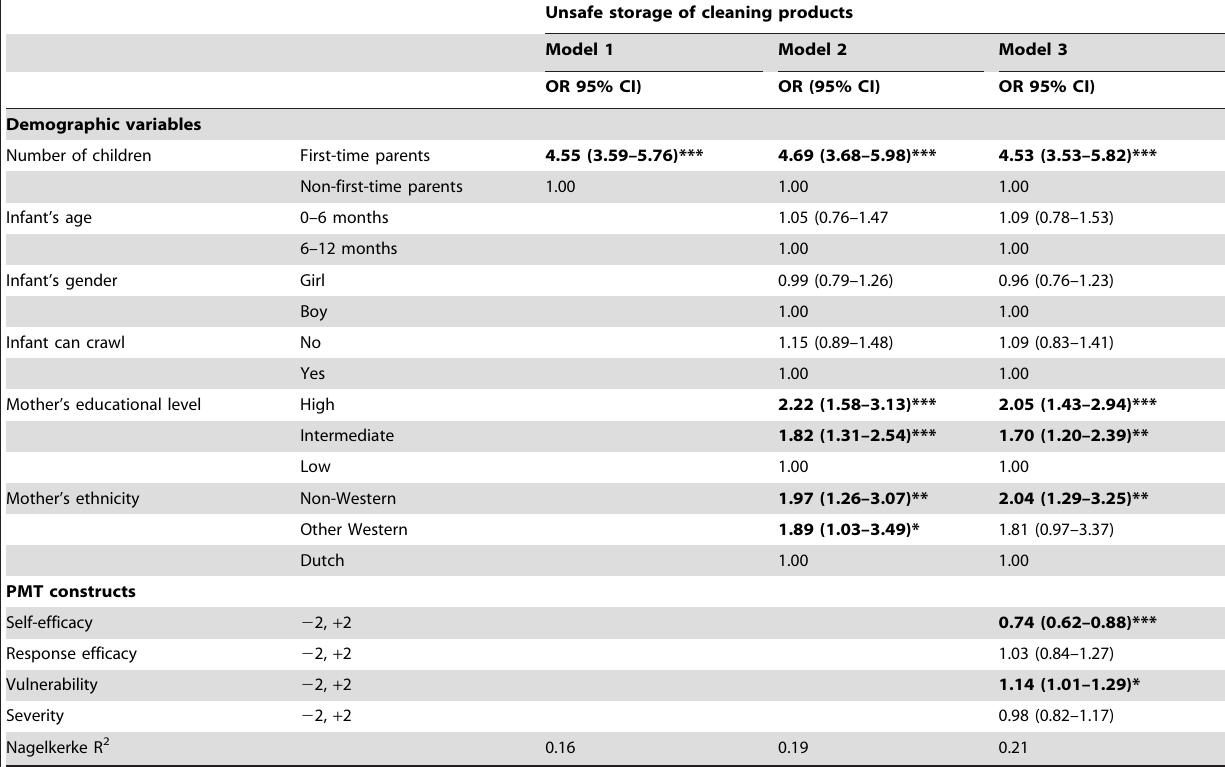
Table 6. Odds ratios (OR), 95% confidence intervals and explained variance (Nagelkerke R 2 ) from multiple logistic regression analyses with reported unsafe storage of cleaning products as dependent variable and number of children (Model 1),